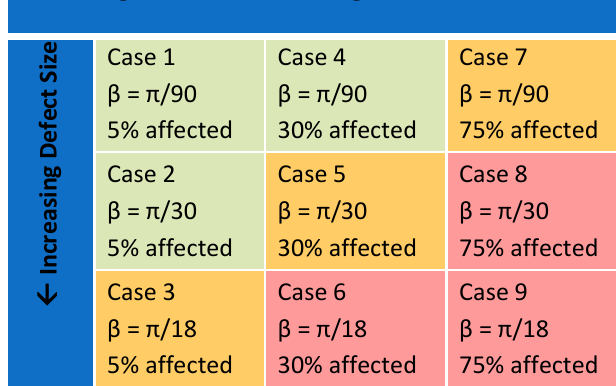
Figure 3. Severity matrix of hypothetical pipe conditions (green = mild, yellow = moderate, and red = severe).